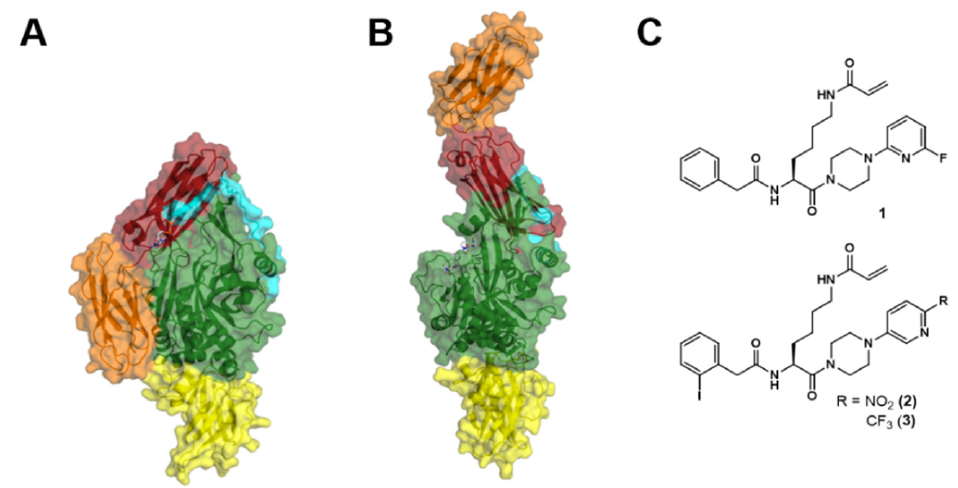
Figure 1. Crystal structures of human (h)TGase 2 in complex with GDP (( A ), “closed” conformation) and with the irreversible inhibitor Ac-Pro-DON-Leu-Pro-Phe-NH 2 (( B ), “open” conformation) are shown as ribbon diagrams with a transparent surface. The N-terminal β -sandwich is colored in yellow, the α / β -catalytic domain in green, the flexible loop in turquoise, and the C-terminal β -barrels in red and orange. The figure was prepared using PyMOL (DeLano, W.L. The PyMOL Molecular Graphics System. Version 1.8 Schrödinger, LLC) and the PDB data 1KV3 [15] ( A ) and 2Q3Z [17] ( B ). Structures of N ε -acryloyllysine piperazides 1 – 3 ( C ).